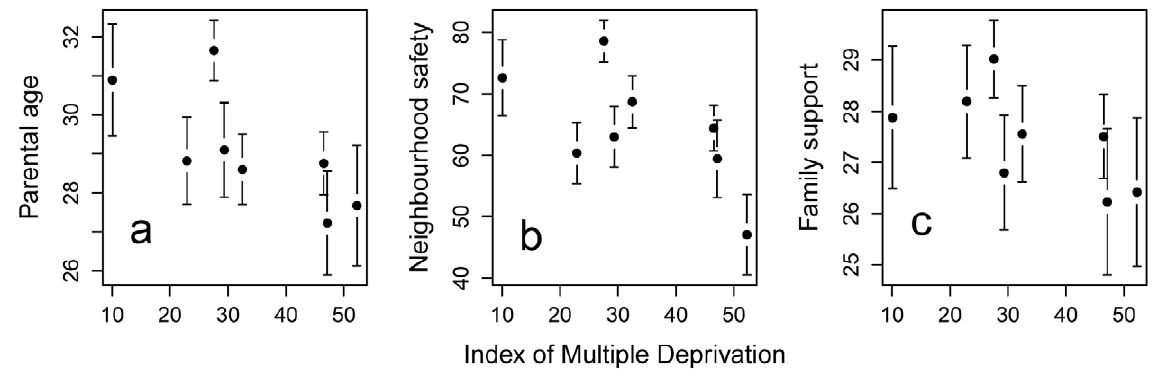
Figure 2. Mean for each neighbourhood of (a) respondent’s parents’ age at the time of their birth; (b) perceived neighbourhood safety; and (c) family support, against the Index of Multiple Deprivation for the neighbourhood. Error bars represent 95% confidence intervals for the mean.